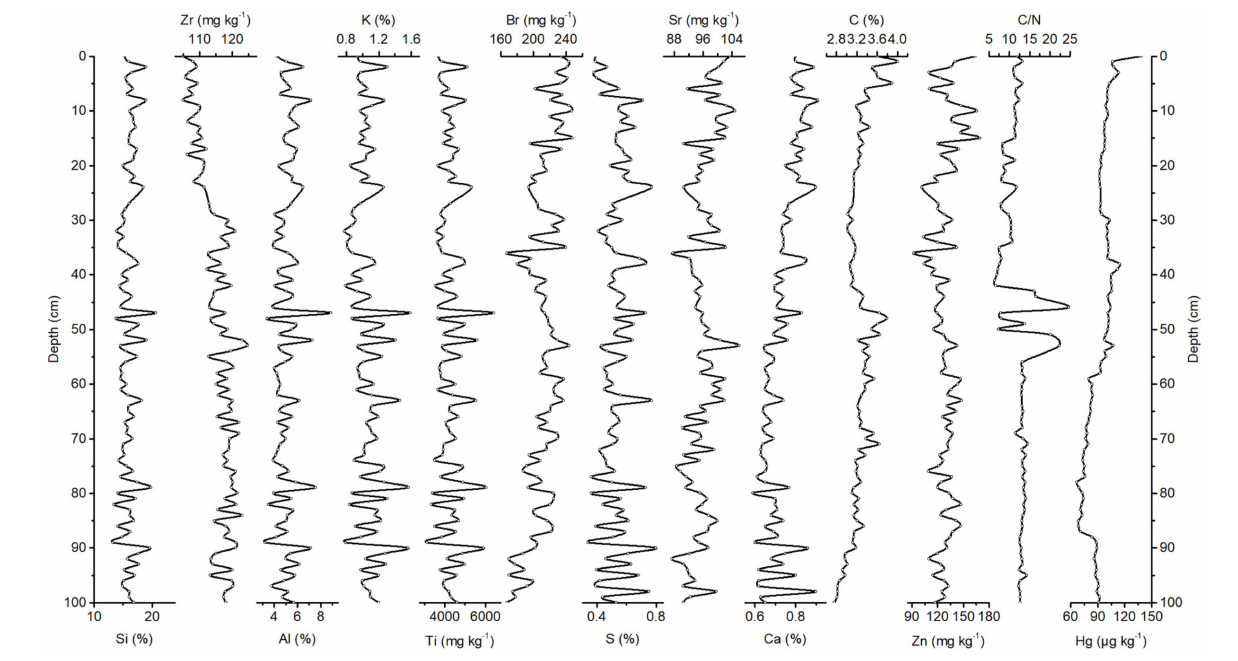
FIGURE 2 | Downcore records of Si, Zr, Al, K, Ti, Br, S, Sr, Ca, C, Zn, and Hg concentrations and C/N ratios of Congo Basin